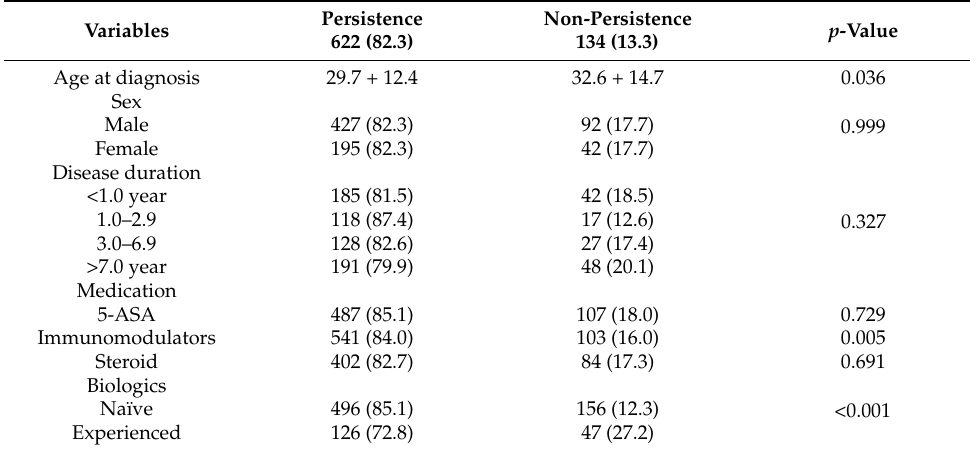
Table 3. Risk factors of non-persistence in adalimumab group.